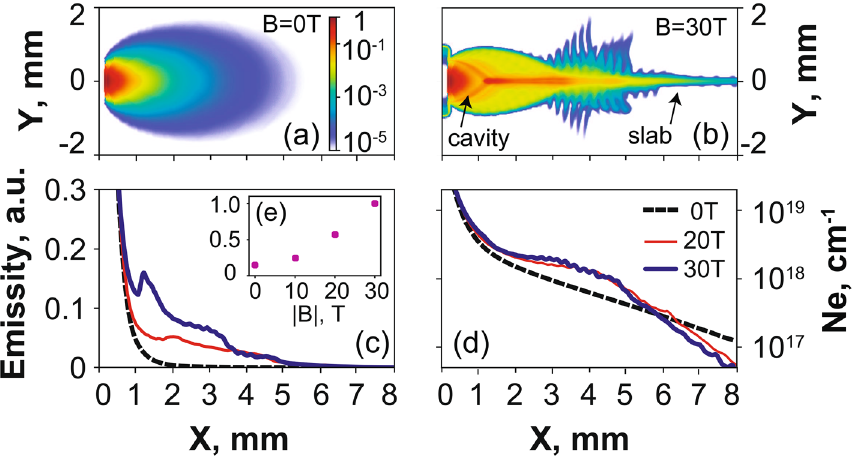
Figure 5. 3D MHD simulation results. ( a , b ) Pseudocolor maps of the relative plasma emission intensity in 0 T and B 30 T, respectively. Images are normalized the XY plane, in logarithm, and for (as indicated) B = = to their own respective maximum, which is distinct for each case. ( c ) Profiles of relative emission intensity, integrated over time (up to 24 ns, which is the maximum time in the simulation) and over the Y and 0 (black, dashed), 20 (red, thin) and 30 T (blue) (similarly as in Fig. 3a). ( d ) Profiles of Z-directions, for B = 0 (black, electron density in logarithm scale, integrated over time and over the Y and Z-directions, for B = dashed), 20 (red, thin) and 30 T (blue). ( e ) Evolution of the integrated plasma emission intensity (normalized to 30 T), integrated in space and time, as a function of the B-field strength. its value at B =